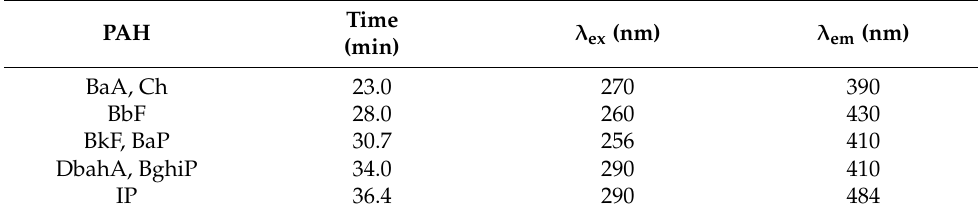
Table 1. FLD wavelength program. λ ex : excitation wavelengths, λ em : emission wavelengths.